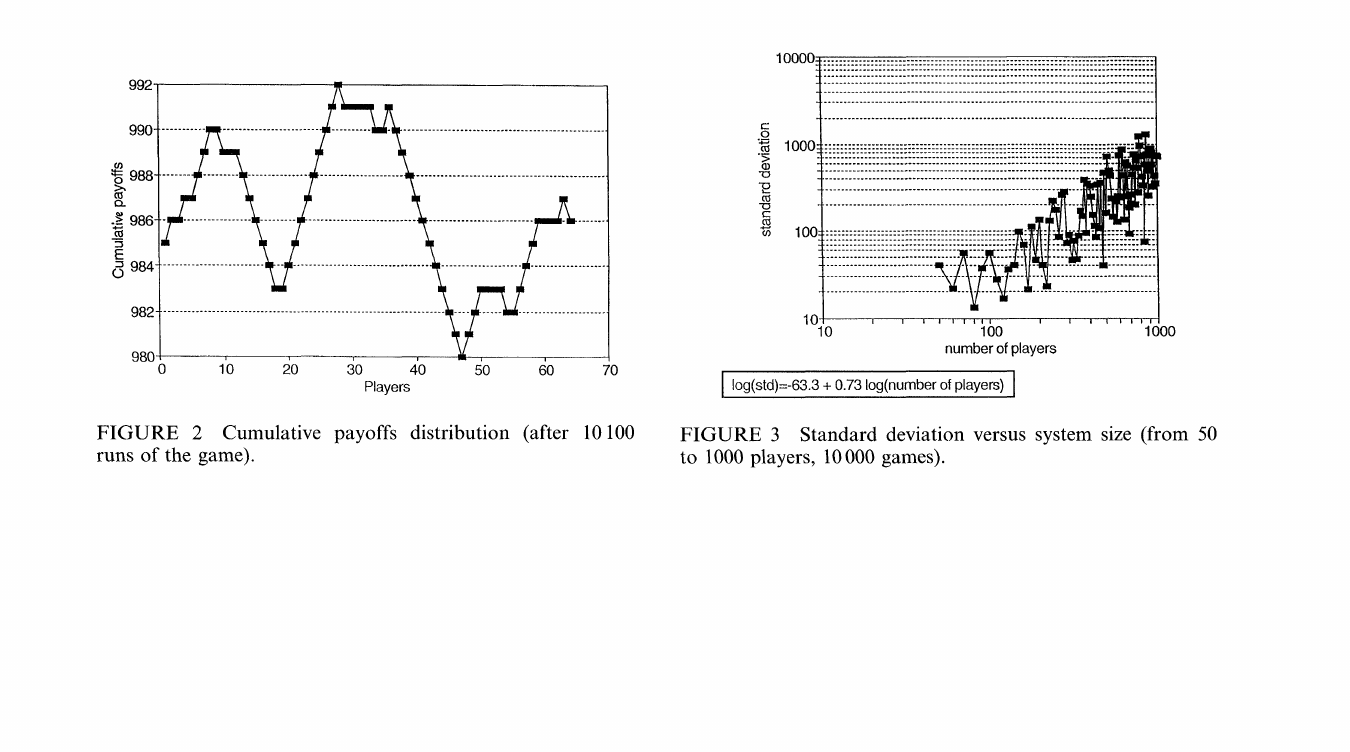
FIGURE 2 Cumulative payoffs distribution (after 10100 runs of the game).